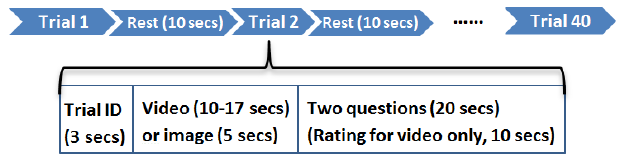
Figure 2. Experimental protocol.